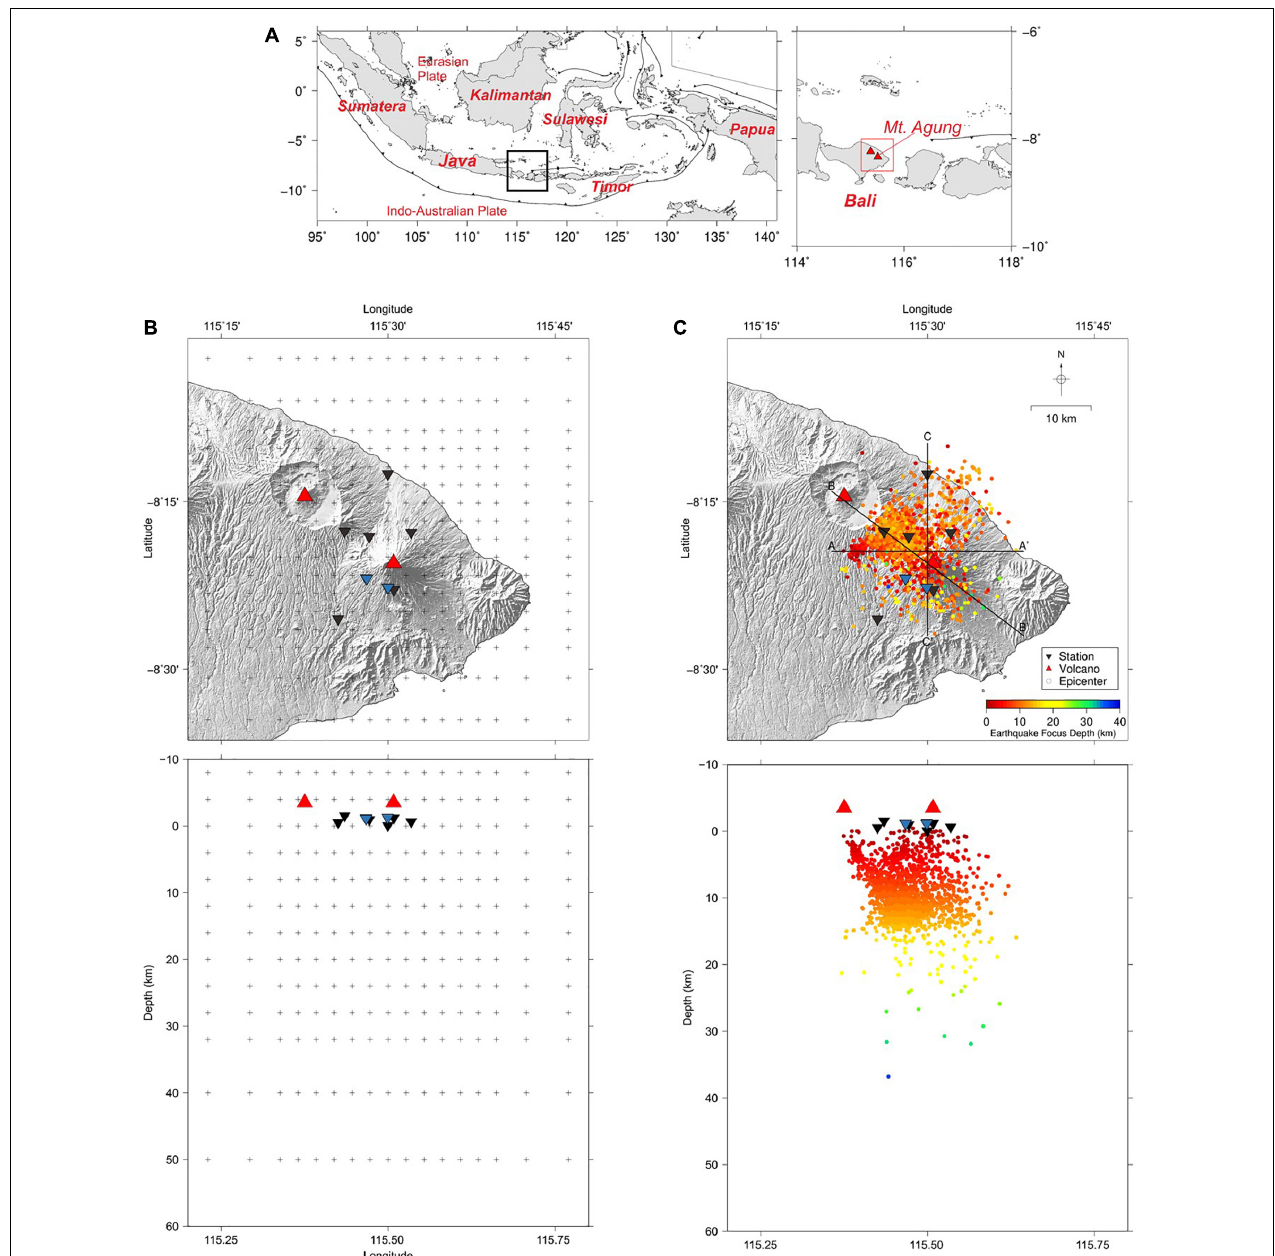
FIGURE 1 | (A) Map of Indonesia: jagged black lines denote the subduction trench; the black square denotes the local area of Bali (right); the red square in the inset map defines the study area. (B) Map of the study area. The red triangles represents the summits of Mt. Agung and Mt. Batur; blue and black inverted triangles show the distribution of the one and three component seismic stations used in this study; exact locations of the seismic stations are provided in Supplementary Table 1 . The grid node location used for tomographic inversion is denoted by black plus symbols. (C) Epicenter and hypocenter distributions of 1, 926 VT events used in this study are shown as colored dots; color indicates the event focal depth. The hypocenters are projected along longitude (below) to show focus depth distribution. Three labeled black lines: A-A’ (east to west), B-B’ (southwest to northeast), and C-C’ (north to south) depict the locations of the vertical cross-sections through Mt. Agung; these sections are used for plotting the synthetic resolution test results ( Figure 2 ) and the seismic velocity structures ( Figures 3 , 4